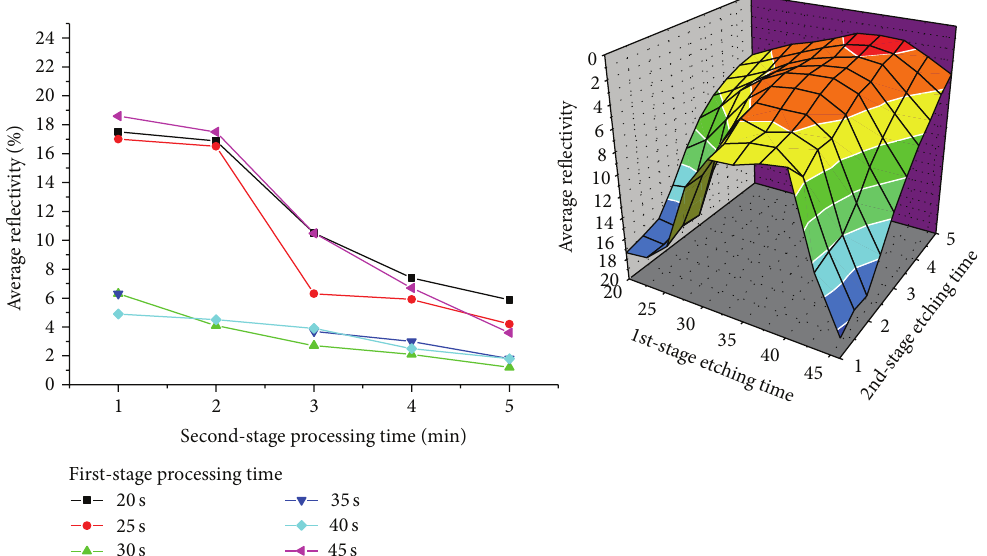
Figure 3: Relationship between the average reflectivity of a micronanohybrid structure fabricated by a certain two-stage MAE process and the corresponding etching time combination in the light spectrum of 200–1000 nm.